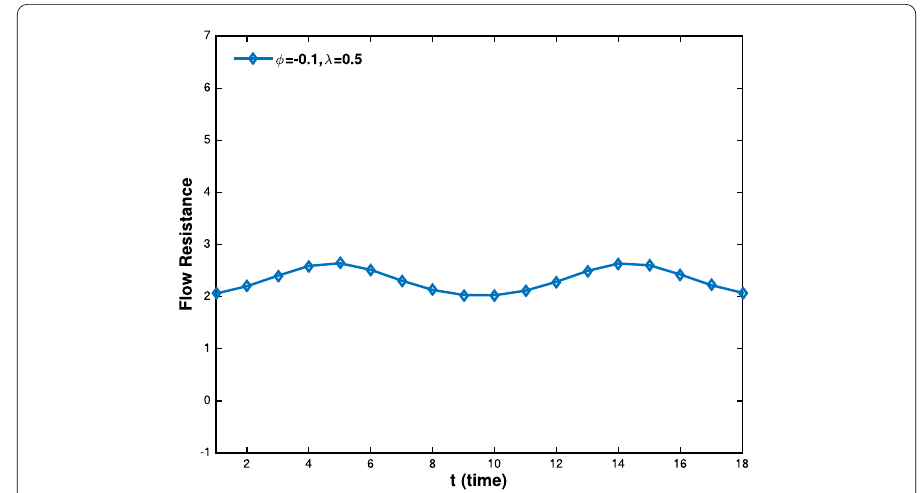
Figure 18 Flow resistance vs time for φ = –0.1 at z = 28, τ y = 0.4, K = 1.6, λ = 0.5